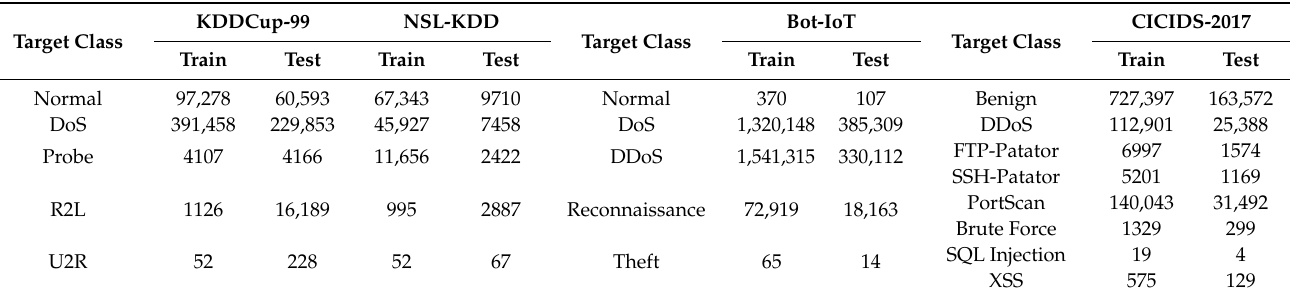
Table 7. Description of the